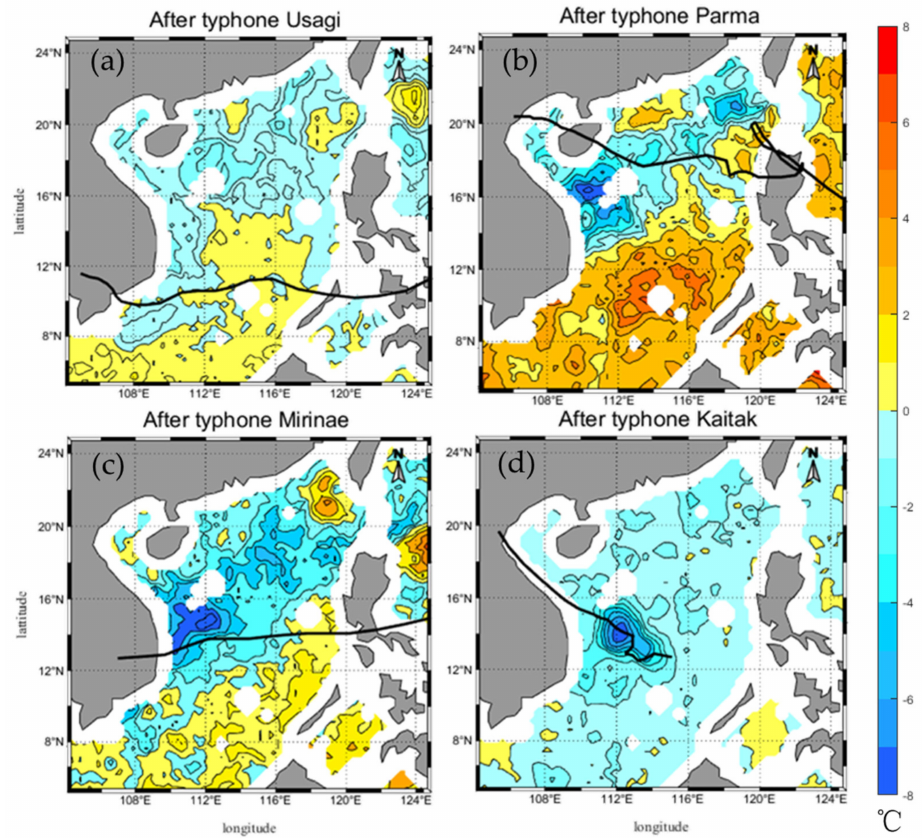
Figure 8. Types of SST changes caused by westward typhoon: ( a ) Describes the change in sea surface temperature one day after Typhoon Usagi; ( b ) Describes SSTA one day after Typhoon Parma; ( c ) Describes SSTA one day after Typhoon Mirine; ( d ) Describes the changes in sea surface temperature on the second day after Typhoon